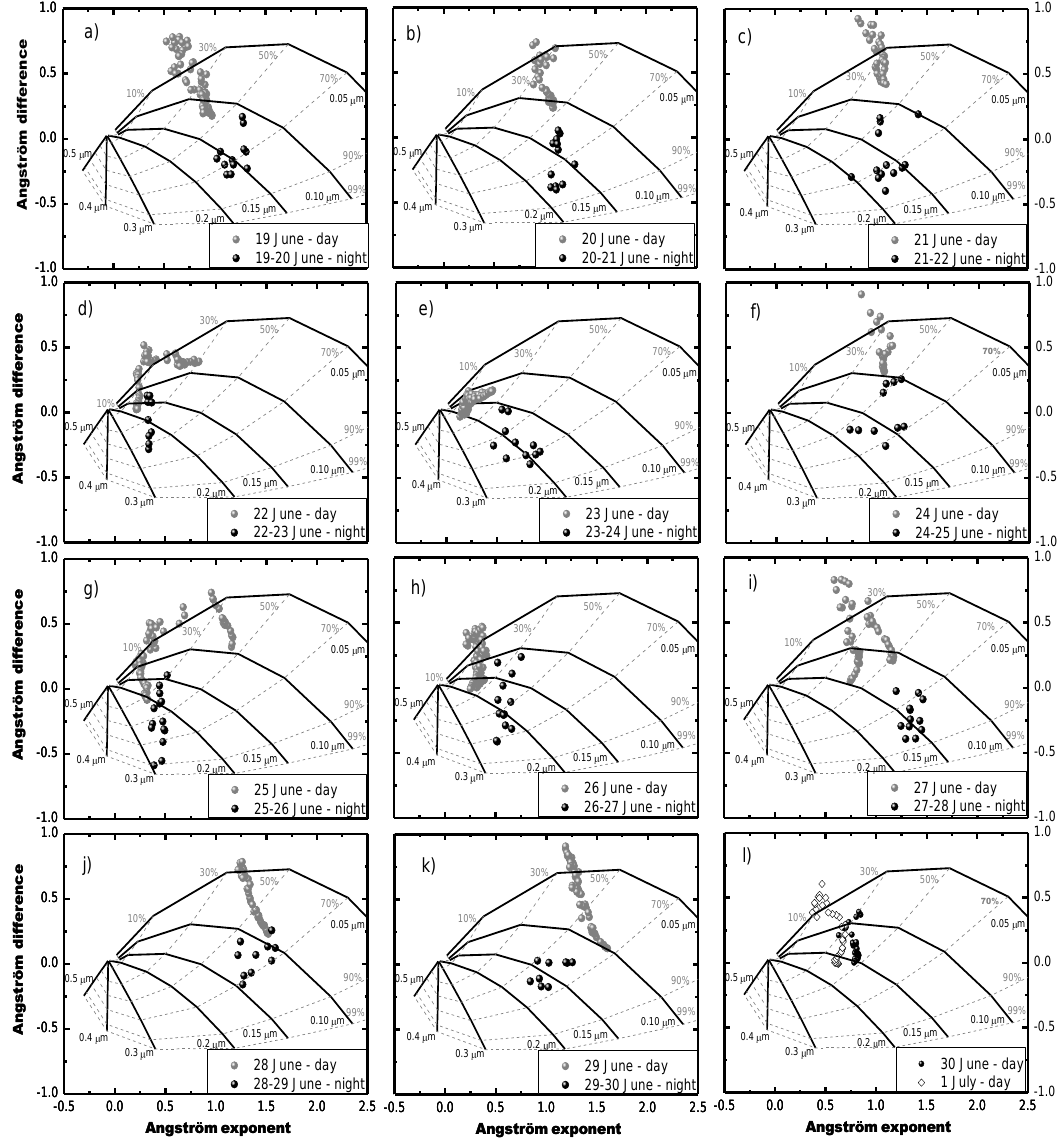
Fig. 10. Angstr¨om exponent difference δα = α (440–670nm) − α (670–870nm) as function of α (440–870nm) at daytime and δα = α Figure 10: Angström exponent difference δα = α(440-670 nm) - α(670-870 nm) as function of α(440-870 nm) at daytime and δα = α(436-670 nm) - α(670-880 nm) as function of α(436-880 nm) at nighttime, for summer case study. The data corresponds to the period from 18 June to 1 July 2008.